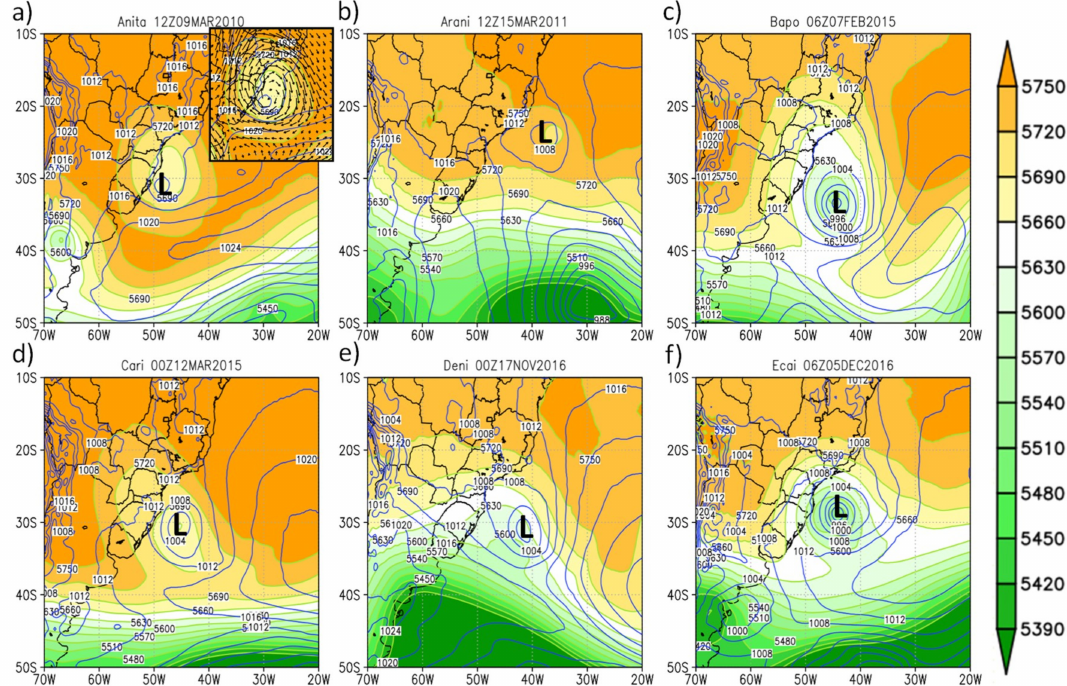
Figure 5. Geopotential height (m) at 500 hPa (shaded and green lines) and sea-level pressure (hPa; blue lines) in the maturity phase of the six subtropical cyclones: ( a ) Anita, ( b ) Arani, ( c ) Bapo, ( d ) Cari, ( e ) Deni and ( f ) Eça í . L indicates the surface low-pressure center. In panel ( a ), a zoomed-in region in the cut-off low area to highlight the easterly winds at 500 hPa is also